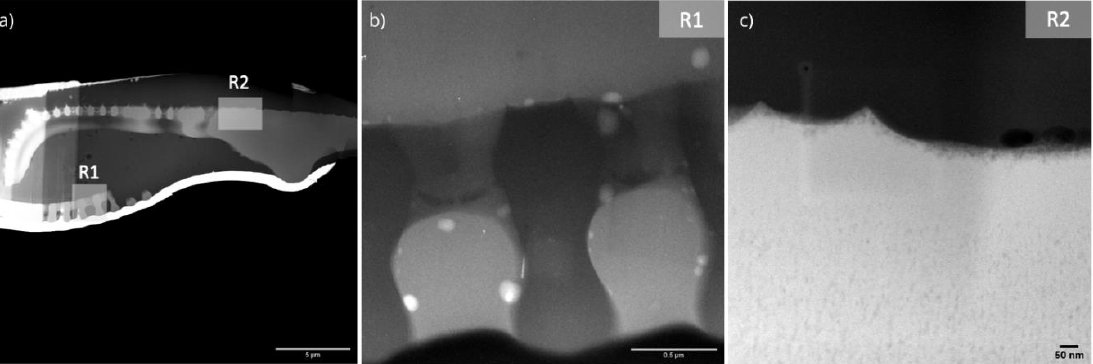
Figure 4. Scanning transmission electron microscopy images of a Didymosphenia geminata frustule sample which prepared by a FIB procedure: ( a ) overview of the lamella (dark field image, scale bar 5µm), ( b ) internal ribs (bright field image, scale bar 0.5 µm), and ( c ) central raphe (dark field image, scale bar 50 nm).